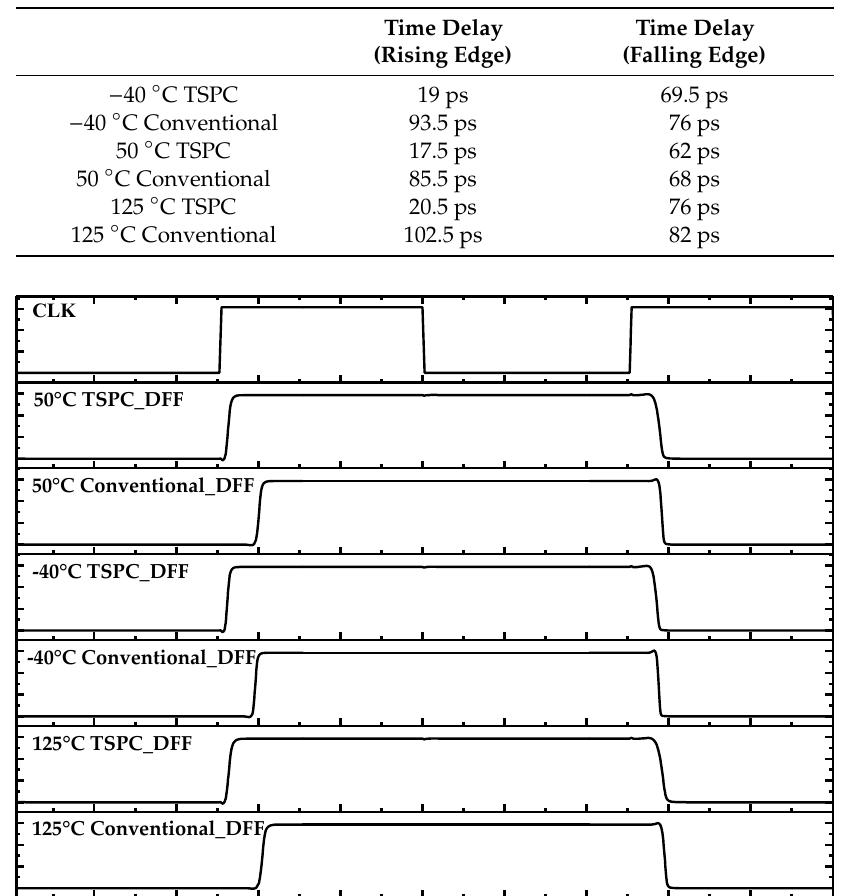
Table 1. Time delay of the two structure of the DFF.